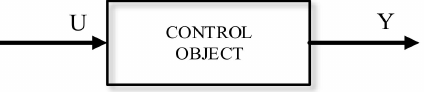
Figure 35. Management process.